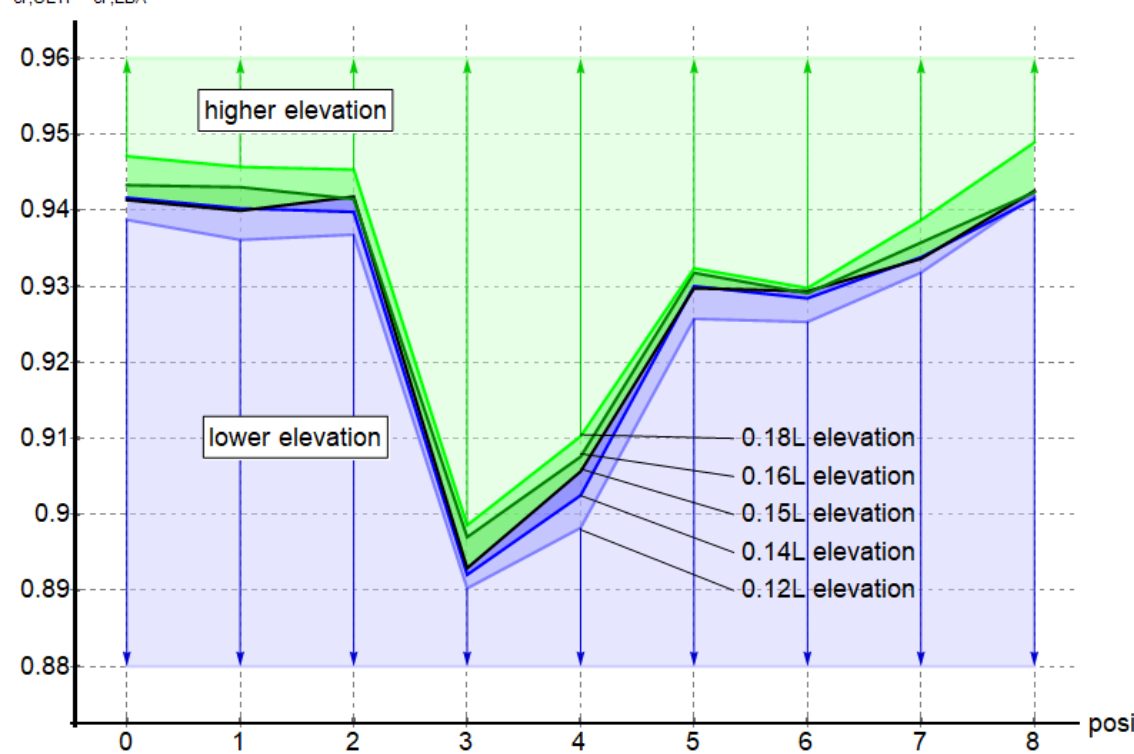
Figure 19: Ranges of ULTI-to-LBA critical load factor ratios for various elevations and predicted trends.